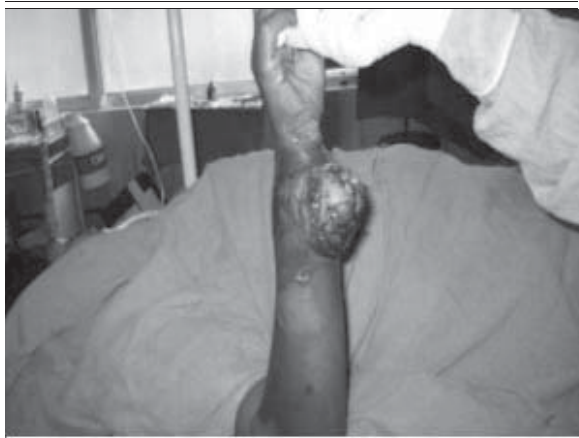
Figure 1 a. Showing clinical photograph with fungating mass